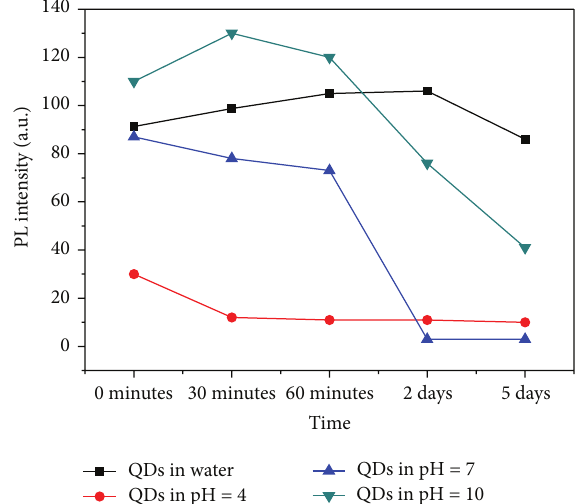
Figure 3: PL spectra of pure QDs in the different buffers tested for different times.